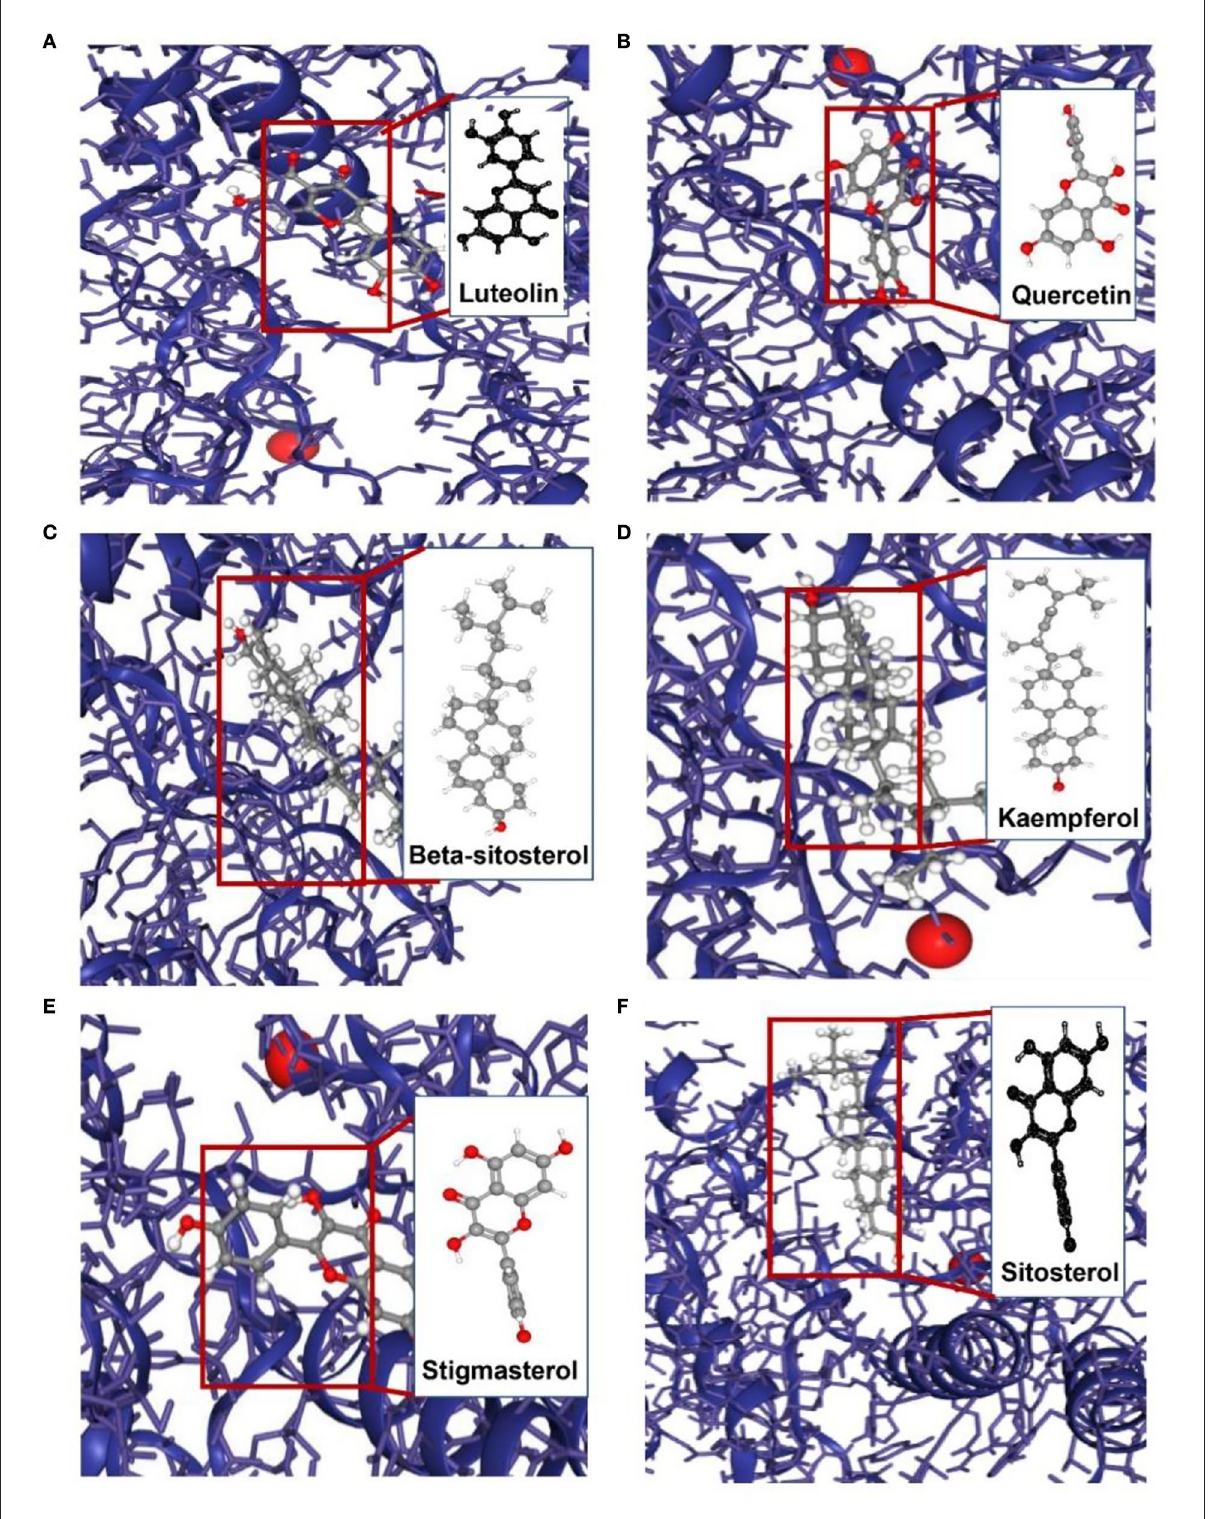
FIGURE5 Molecular models of the binding of MAPK14 with (A) luteolin, (B) quercetin, (C) beta-sitosterol, (D) kaempferol, (E) stigmasterol and (F) sitosterol.